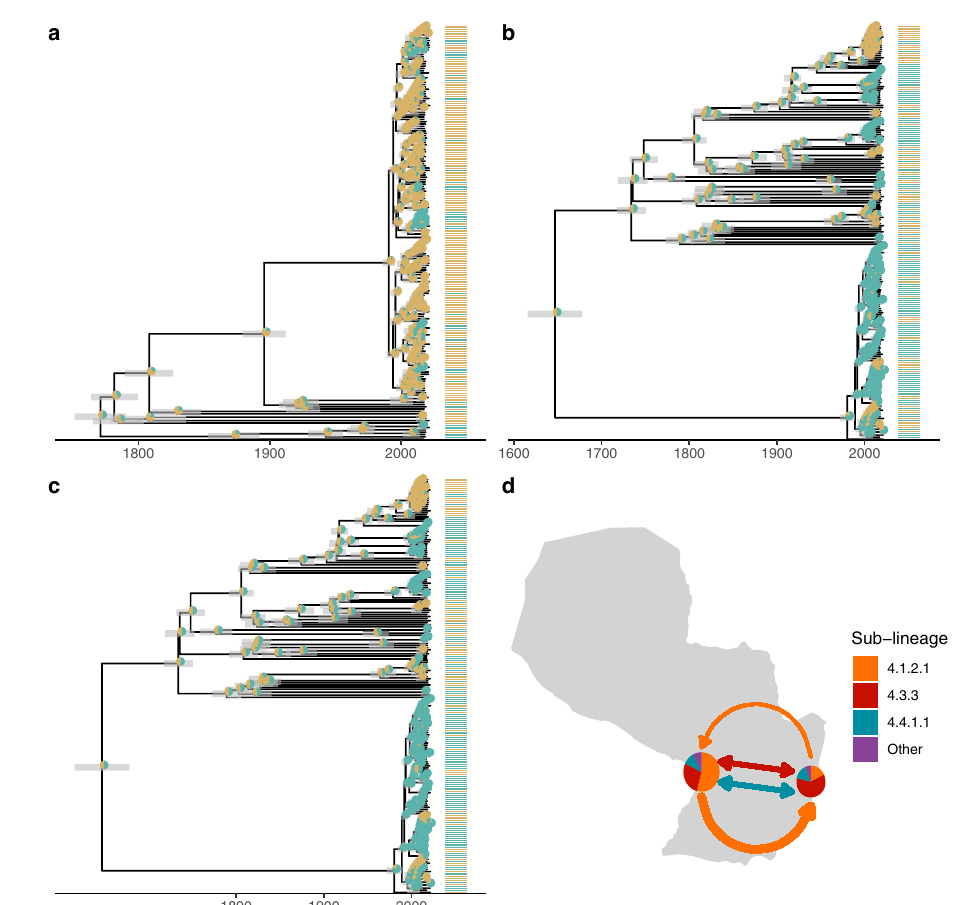
Fig. 4 | Frequent gene fl owof M.tuberculosis connectsParaguay ’ s majorurban centers. a – c We used discrete ancestral state reconstruction to reconstruct migration between the two cities for the three dominant sub-lineages in our sam- ple; lineages 4.1.2.1, 4.3.3, and 4.4.1.1. Bayesian maximum clade credibility trees of samples in the three dominant sub-lineages with tip points colored by city of sampling and pie charts atnodes indicating the inferred ancestral location. Branch lengths are in years and grey bars indicate 95% high posterior density estimates of